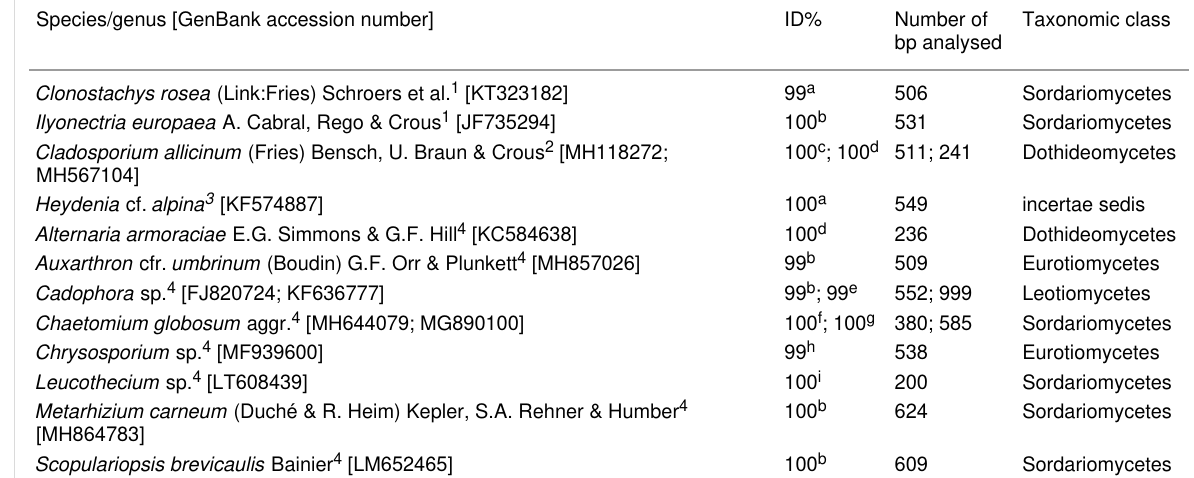
Table 1: Fungal taxa obtained by four FIND experiments and identified by sequence comparison with the best BLASTn match within the NCBI GenBank database. Species/genus [GenBank accession number] ID% Number of